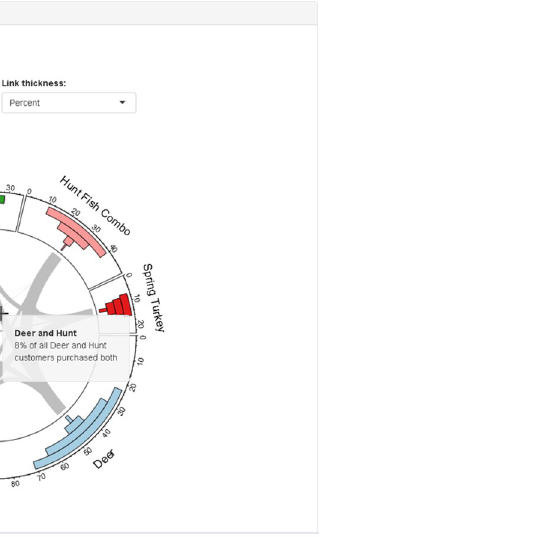
Vertical lines connecting dots in relevant rows indicate combination of items purchased. The vertical bar graph has a bar for each column in the table to indicate the number of customers who purchased that particular combination of items. The horizontal bar graph has a bar for each row in the table to indicate the total number of customers who purchased each item type irrespective of other purchases.